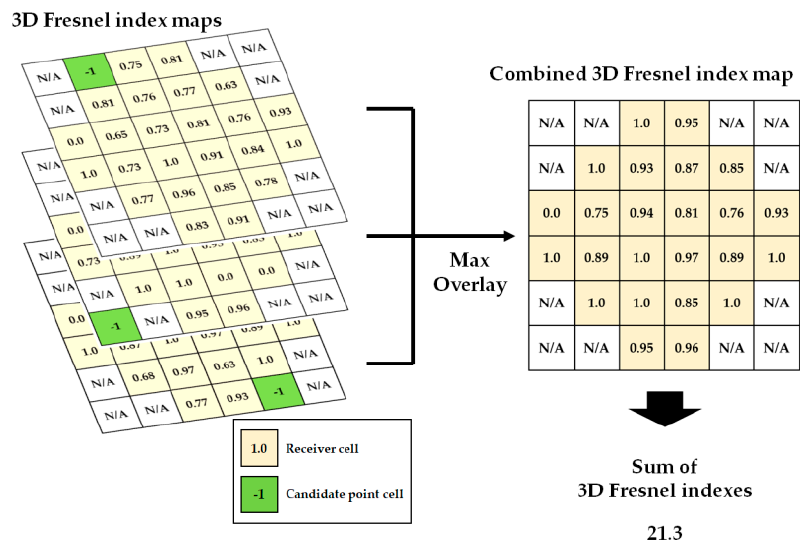
Figure 4. Example showing generation of a 3D Fresnel index overlay map.